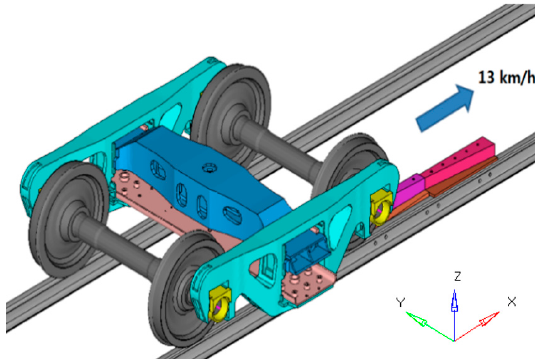
Figure 7. The condition of the derailment simulation.